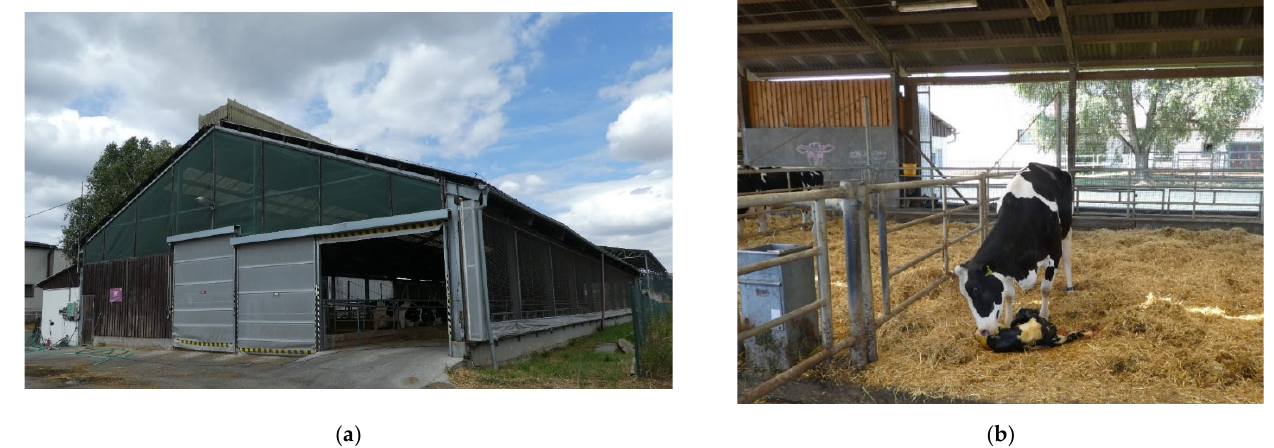
Figure 3. The maternity cowshed (MC): ( a ) exterior view; ( b ) the interior of the maternity cowshed. Individual outdoor hutches (CaH) (Figure 4) for housing calves in the first breeding period up to 2 months of age are made of white polyethylene. All the CaH have a length of 150 cm, a width of 112 cm, and a height of 135 cm. The floor is covered daily with new straw bedding.